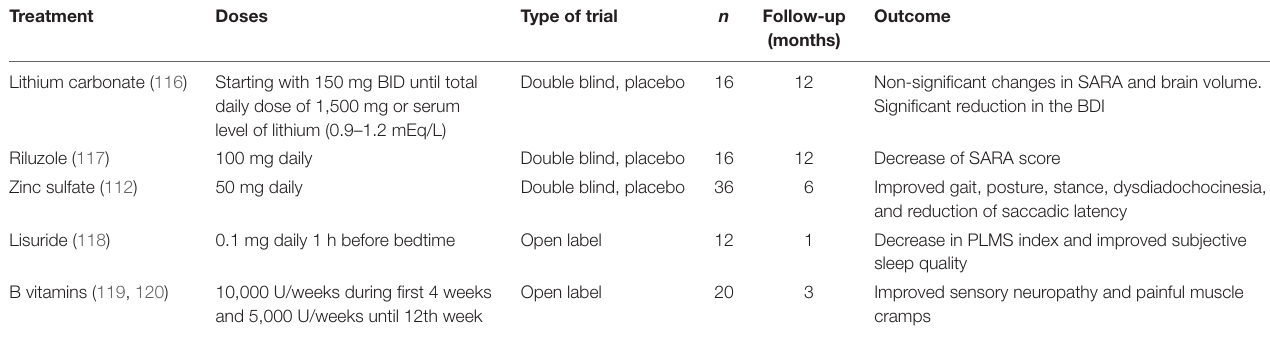
TABLe 1 | Clinical trials in spinocerebellar ataxia type 2